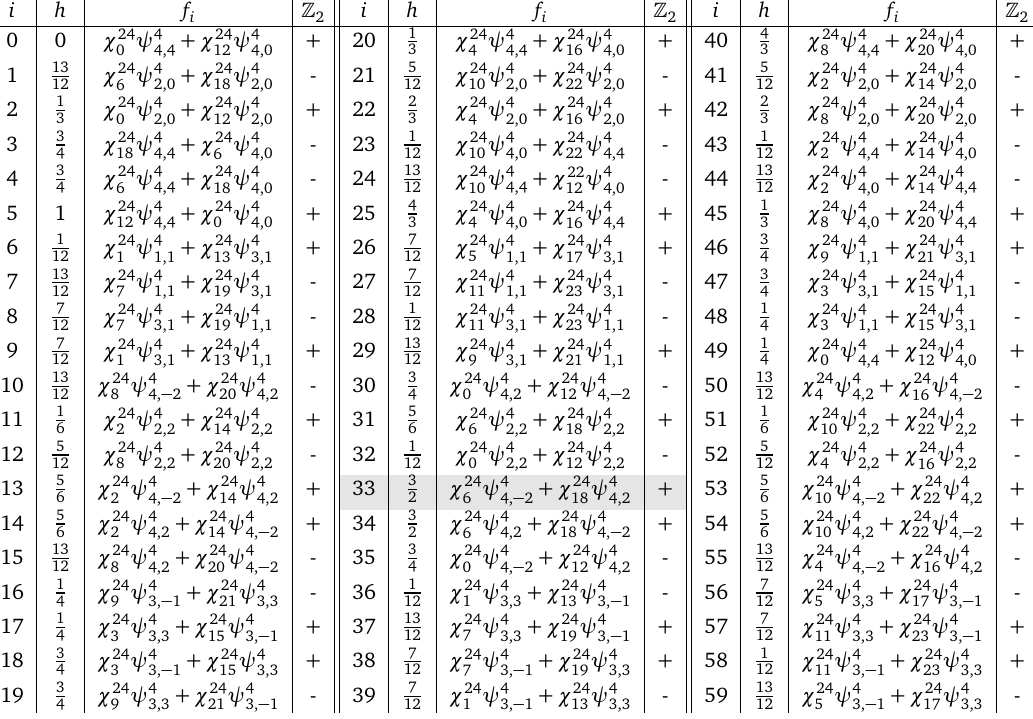
(cid:0) (cid:1) / × ( (cid:90) U ( 1 ) Table 28: parafermion CFT) ( (cid:90) ): The conformal characters f 24 4 4 ( i = 0,1, ··· ,59) can be expressed in terms of the characters of the U ( 1 ) Parafermion CFT, denoted by χ l = 24 and ψ k = 4 . We highlight the primaries related to the discrete (cid:96) , m i (cid:90) symmetry of the 2